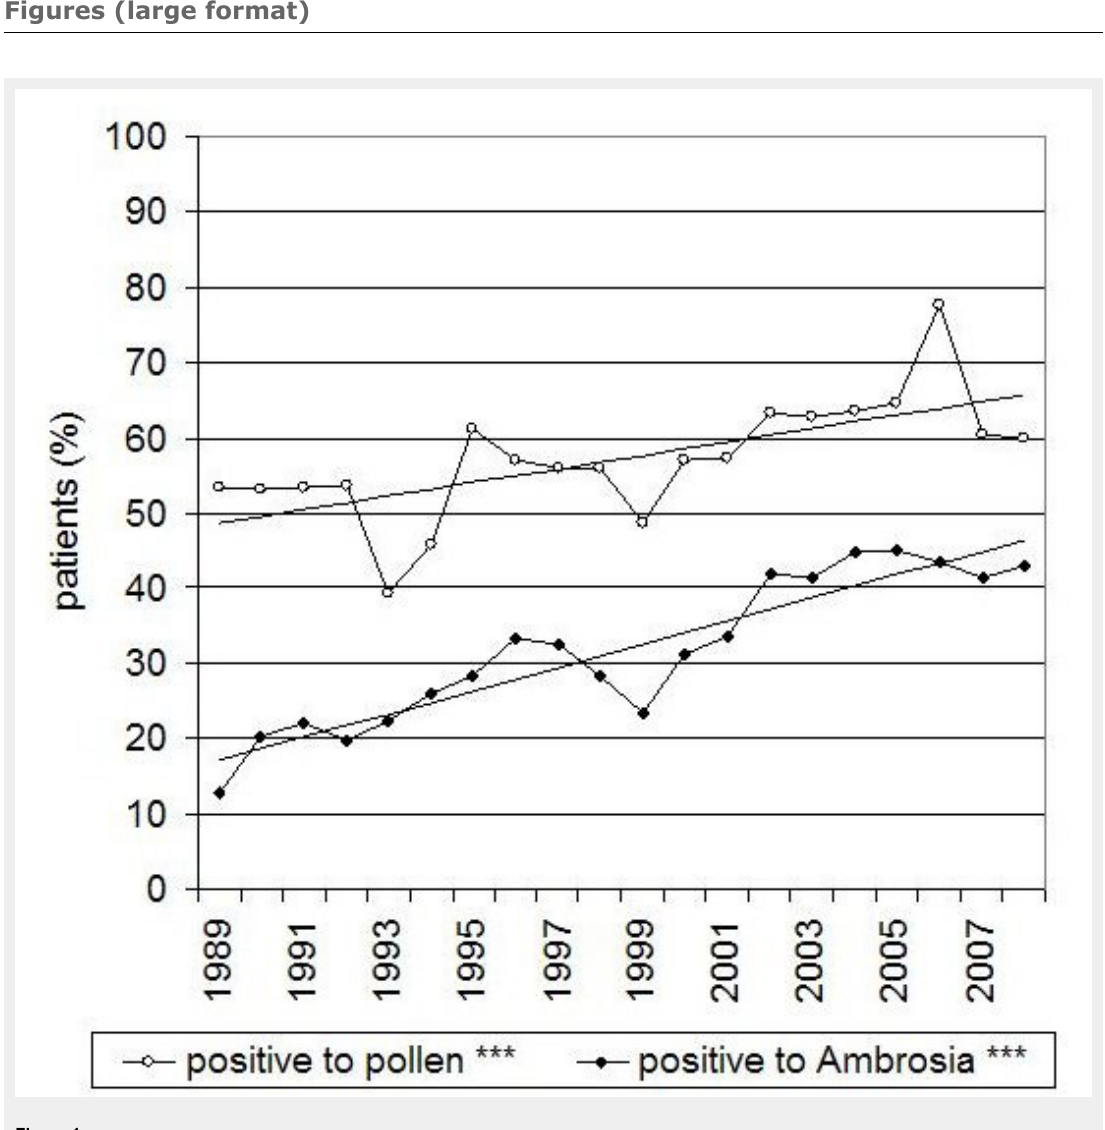
Figure 1 Increase of sensitisation among patients in Legnano. The significance of the trends was calculated using the Mann-Kendall trend test: p